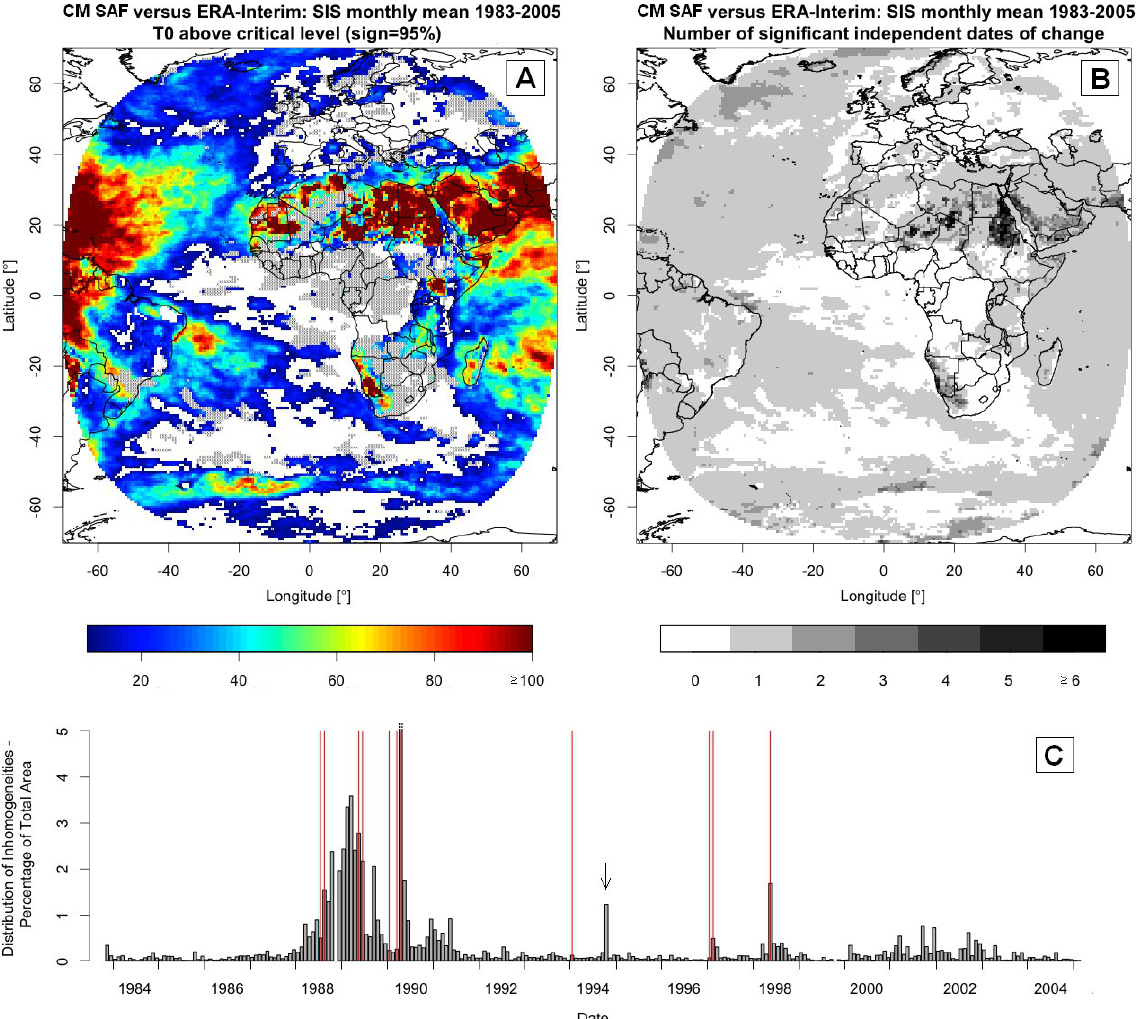
Figure 8. Relative SNHT analyses of the CM SAF SIS series vs . ERA-Interim SIS using the filter condition mentioned in the text. ( A ) T values above a significance level of 0 95% for CM SAF SIS data (grey shaded areas mark the filtered regions); ( B ) number of detected inhomogeneities; and ( C ) distribution of the frequency of breaks (in percent of total area). Satellite changes are indicated by vertical lines. The arrow marks the date of a retrieval